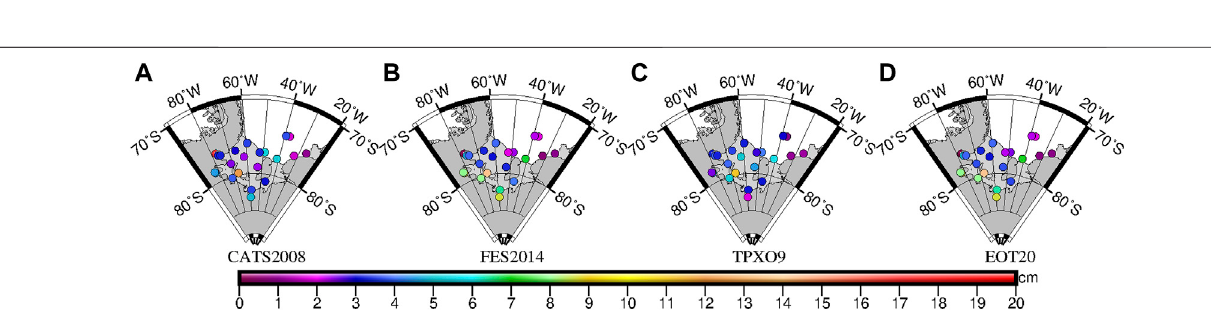
Frontiers in Earth Science |